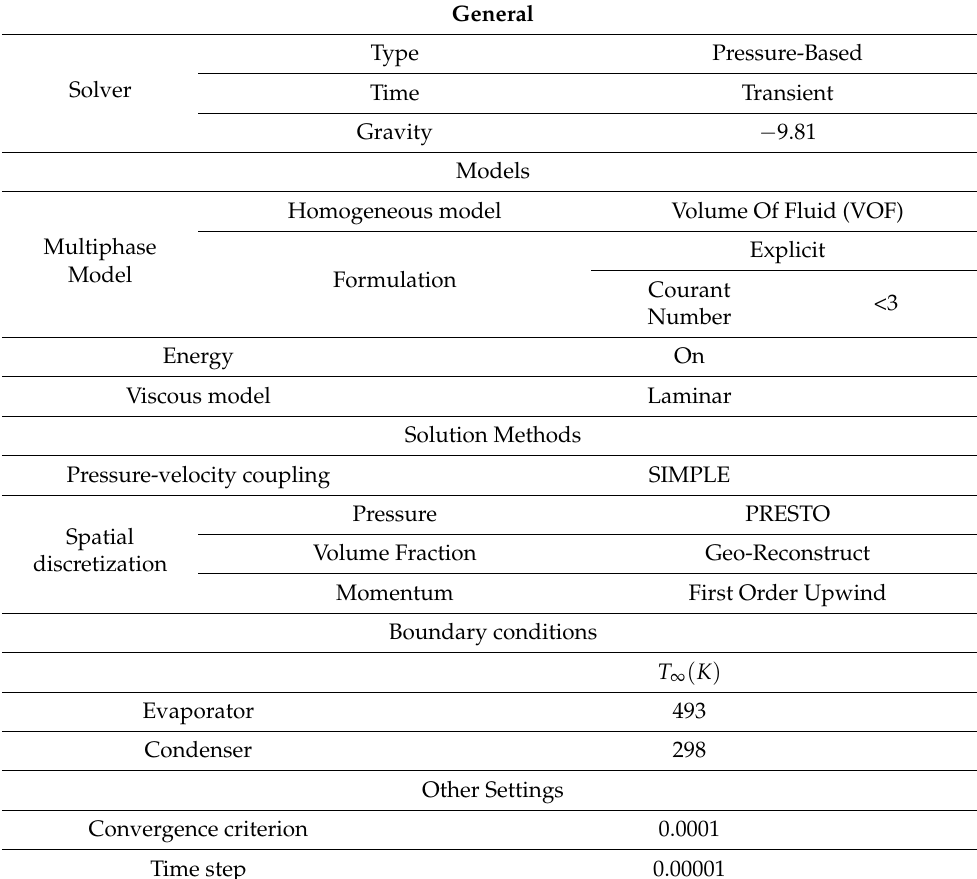
Table 1. Summary of the parameters in